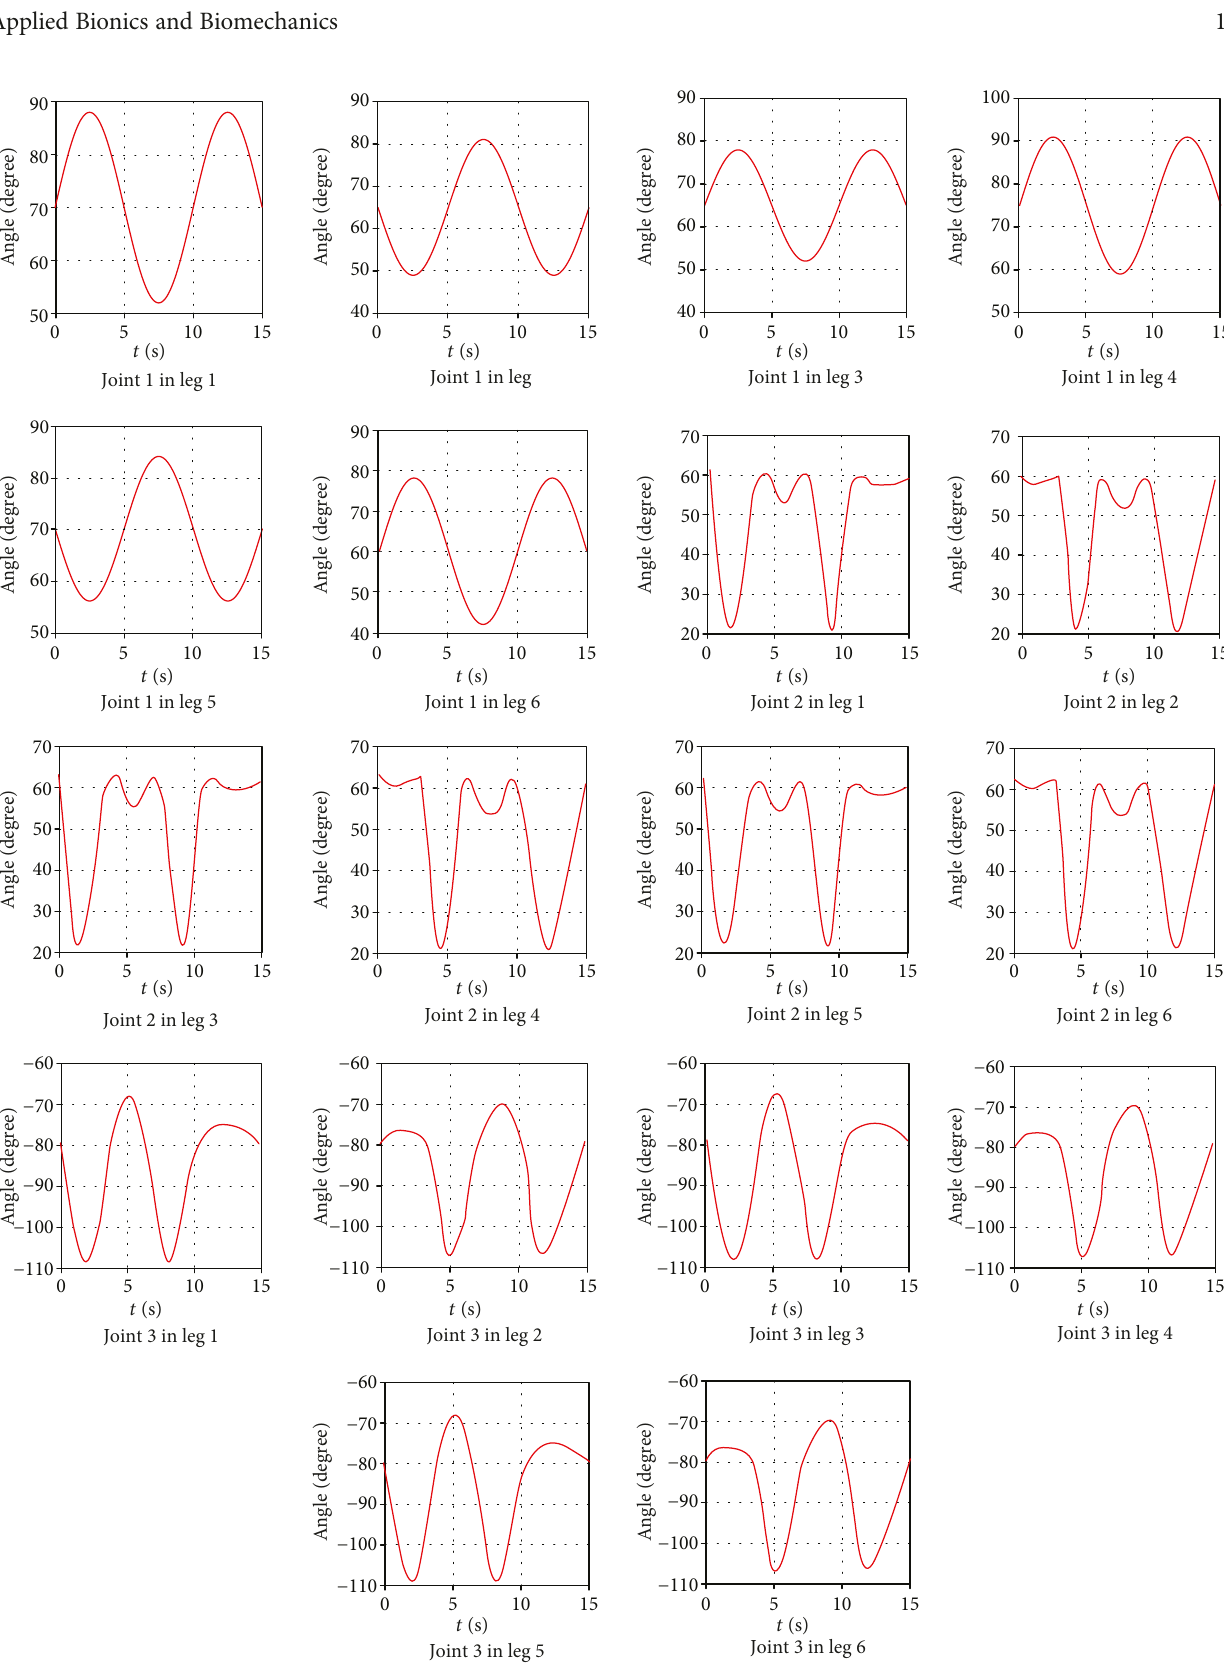
Figure 13: The driving function of the driving